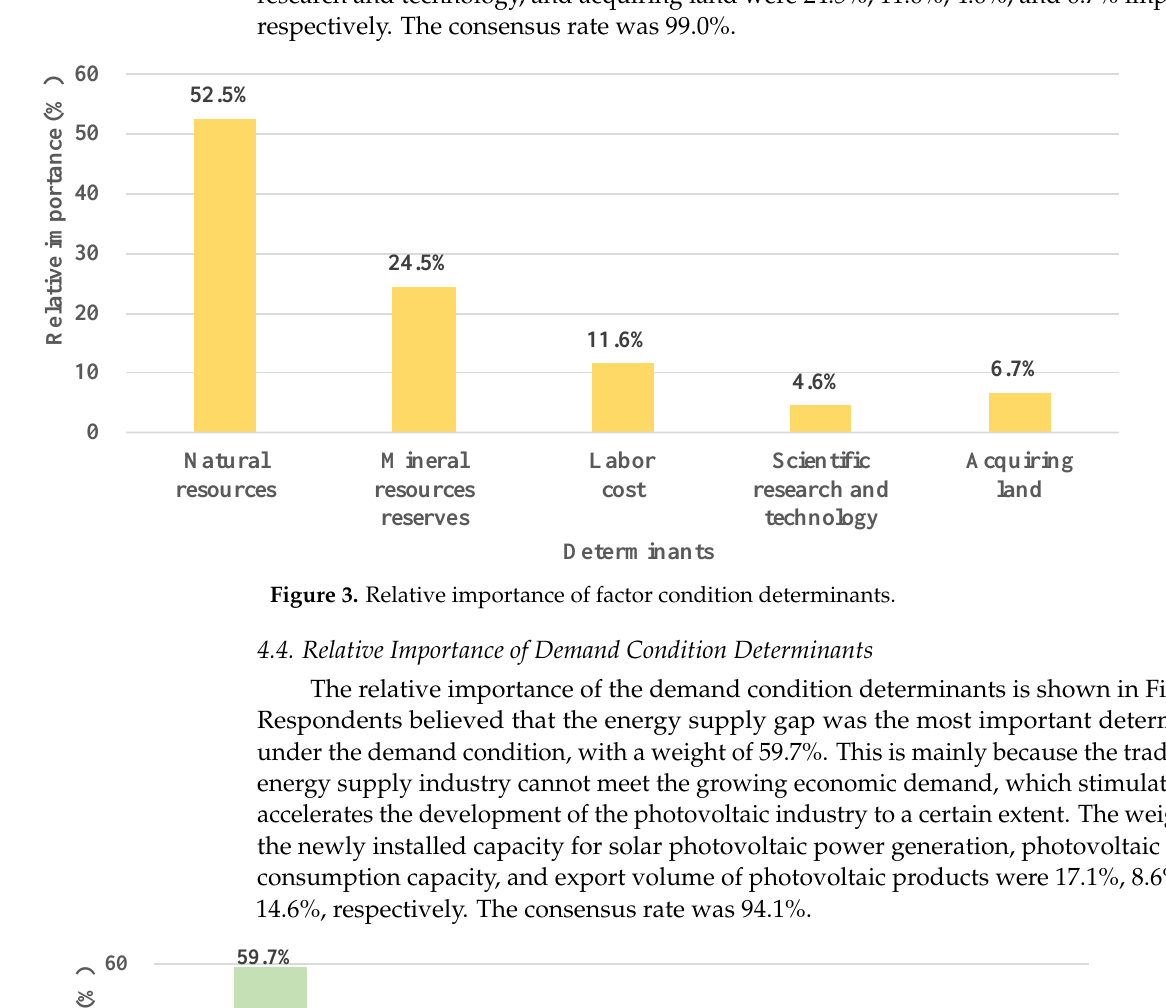
Figure 2. Relative importance of the six categories.